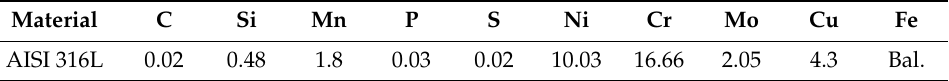
Table 1. Chemical compositions of commercial grade AISI 316L. Material